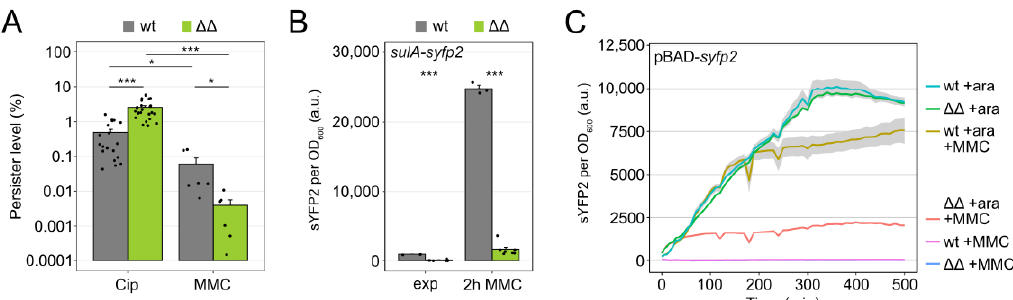
Figure 5. Mutant ∆ 1-41 ∆ istR is highly susceptible to mitomycin C. ( A ) Colony counts were determined before and after six hours of Cip (1 µ g mL − 1 ; 100 × MIC) or MMC treatment (wt: 10 µ g mL − 1 ; ∆∆ : 2.5 µ g mL − 1 ; 4 × MIC). Colony counts were used to calculate persister levels. Bars represent the mean ( ± SEM; n ≥ 6). A pairwise t -test was performed to compare persister levels (* p < 0.05, *** p < 0.001). Black dots indicate the results of individual biological experiments. ( B ) sYFP2 fluorescence from a chromosomal sulA-syfp2 fusion was monitored in a microplate reader. Reporter strains were analyzed during the exponential phase (exp, OD 600 of ~0.4) and after two hours of MMC treatment (wt: 10 µ g mL − 1 ; ∆∆ : 2.5 µ g mL − 1 ; 4 × MIC). Fluorescence measurements were background-corrected and normalized to OD 600 . Bars represent the mean ( ± SEM; n ≥ 3). A pairwise t -test was performed to compare wt and ∆∆ (*** p < 0.001). Black dots indicate the results of individual biological experiments. ( C ) sYFP2 fluorescence from plasmid pBAD- syfp2 was monitored in a microplate reader. sYFP2 expression was induced by 0.2% L-Ara (+ara) 30 min before treatment with MMC (wt: 10 µ g mL − 1 ; ∆∆ : 2.5 µ g mL − 1 ; 4 × MIC). Treatments with L-ara or MMC alone served as controls. Fluorescence measurements were normalized to the corresponding OD 600 measurements. Data represent the mean (colored lines) and SEM (grey ribbons; n = 3). (wt: wild type MG1655; ∆∆ : ∆ 1-41 ∆ istR